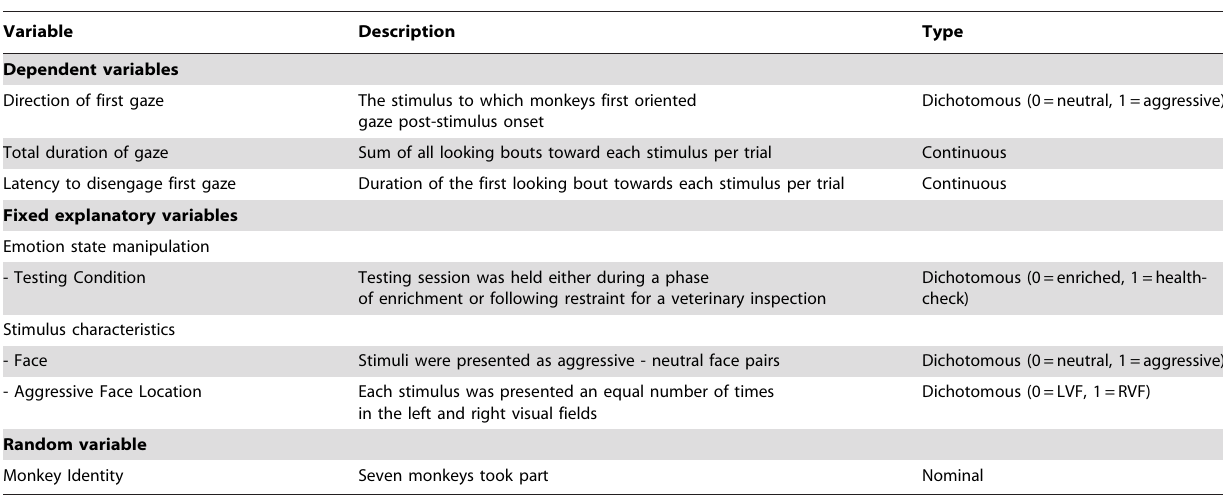
Table 1. Variables used in the GLMM